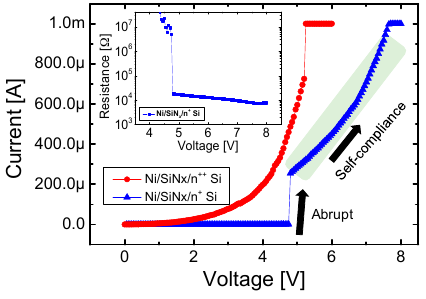
Figure 5. Self-compliance behavior in the LRS for the Ni/SiN x /n ++ Si and Ni/SiN x /n + Si devices.